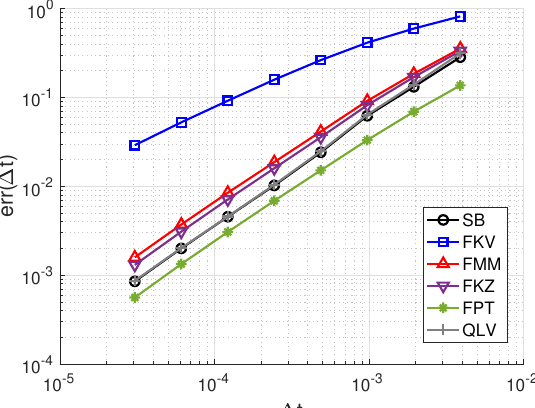
Figure 7. Convergence analysis for the fractional visco-elasto-plastic models under cyclic loads. Due to the particular choice of fractional orders (with β 2 = β K = 0.7 being dominant), we observed the convergence rate of q ≈ 1.3 for all models except for the FKV. In the latter case, we observed a linear convergence to the reference